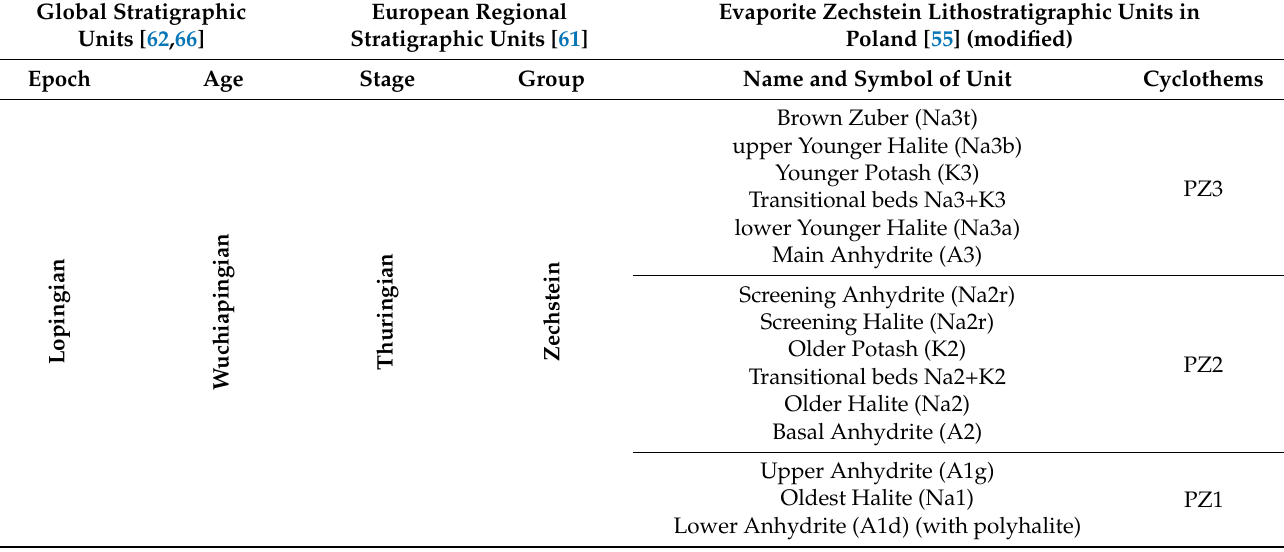
Table 1. Stratigraphy of commented evaporite Zechstein succession in Poland with studied potash- bearing